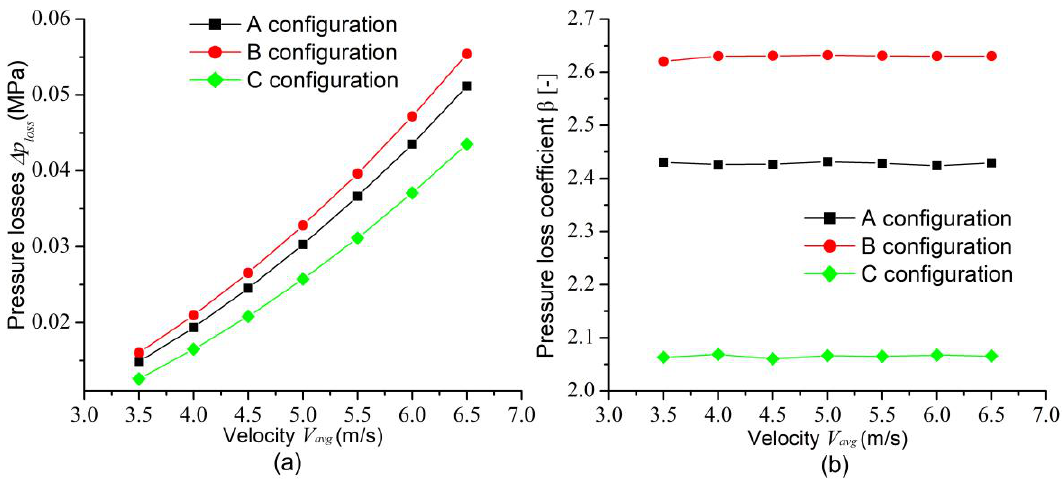
Figure 16. Influence of inlet velocity on the total pressure loss: ( a ) pressure losses; ( b ) pressure loss coefficient.